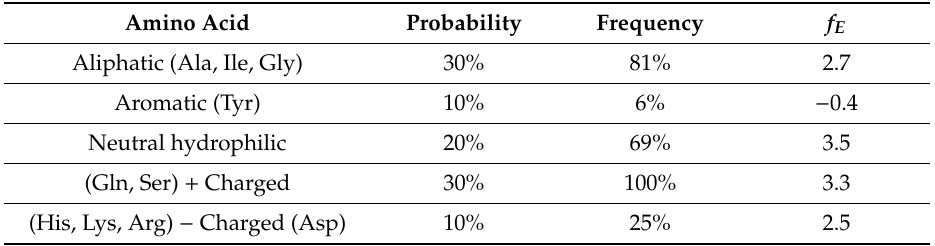
Table A2. Factor of amino-acid enrichment (f E ) produced by the library screening, calculated as the ratio between the frequency of a group of amino acids in the identified sequences and the probability of finding it in a random peptide in the